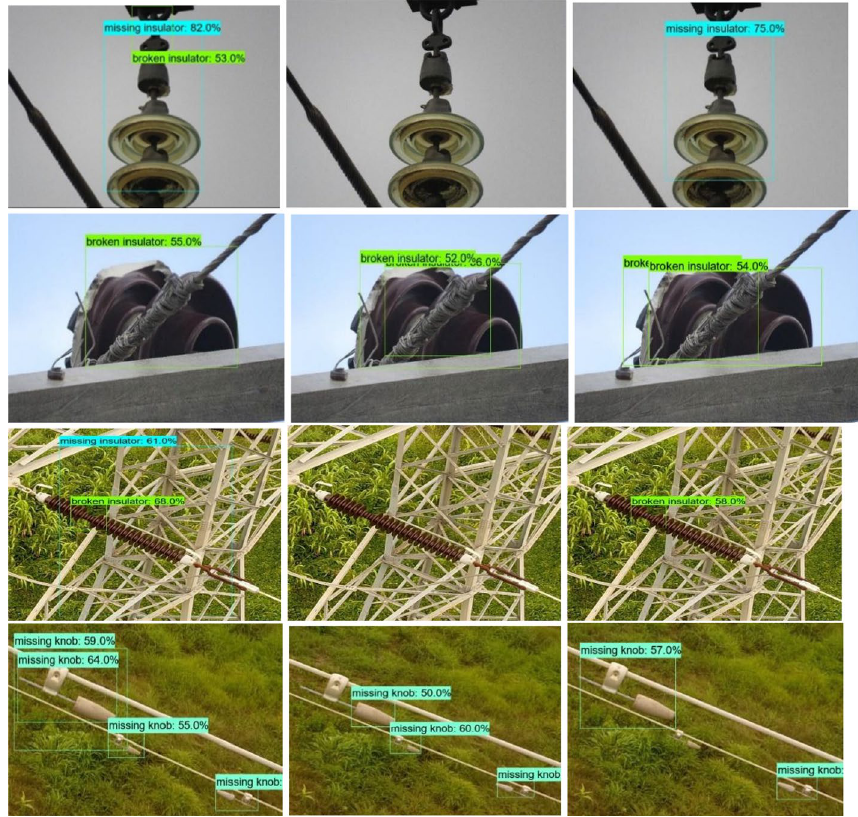
proposed method’s performance in each row, SSD MobNet, SSD Rest50, and SSD